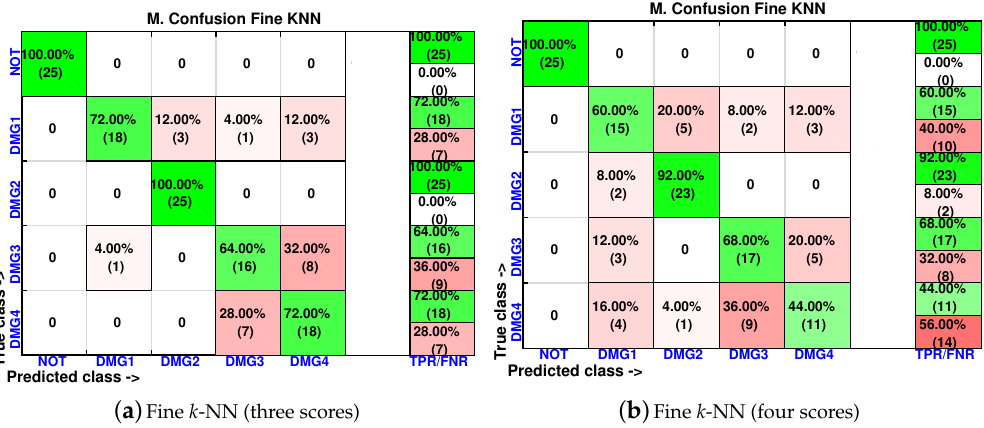
Figure 21. Confusion matrix using fine k -NN when the feature vector is formed by the first three principal component ( a ) or by the first four principal components ( b